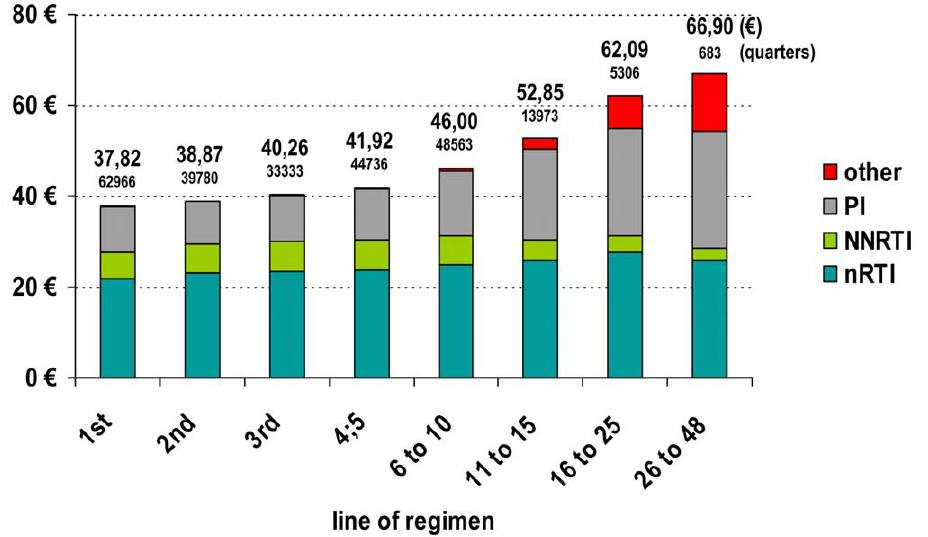
Figure 5. Direct costs of antiretrovirals per line of regimen (pharmacy prices including taxes in Euros. Fine-printed numbers represent sample sizes. p , 0.0001 for differences between regimen line groups).